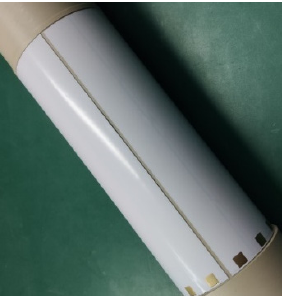
Figure 1. ECT sensor machined with FPC electrode process and cut PEEK pipe process.